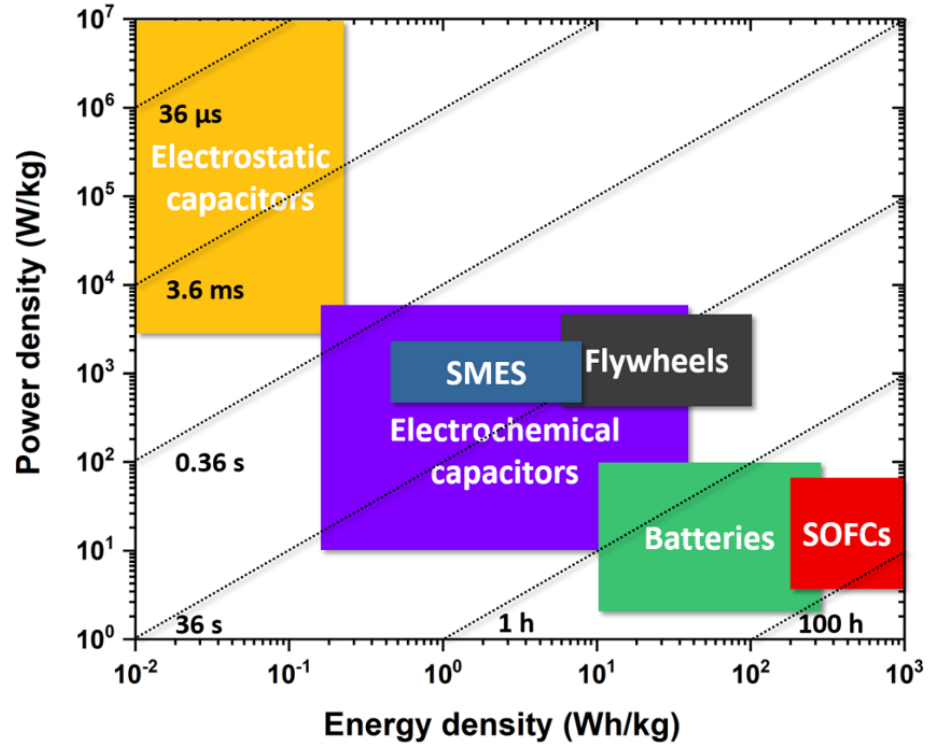
Figure 1. Log-scale Ragone plot showing a performance comparison between different energy storage devices, including superconducting magnetic energy storage (SMES). Conceptually, the energy density (Wh/kg, vertical axis) describes how much energy is available, while the power density (W/kg, horizontal axis) shows how quickly the energy can be delivered. The sloping lines indicate the required time to get the charge in or out of a device [40]. Table 1. Comparison of energy storage performance between representative dielectric films and between representative dielectric bulks.